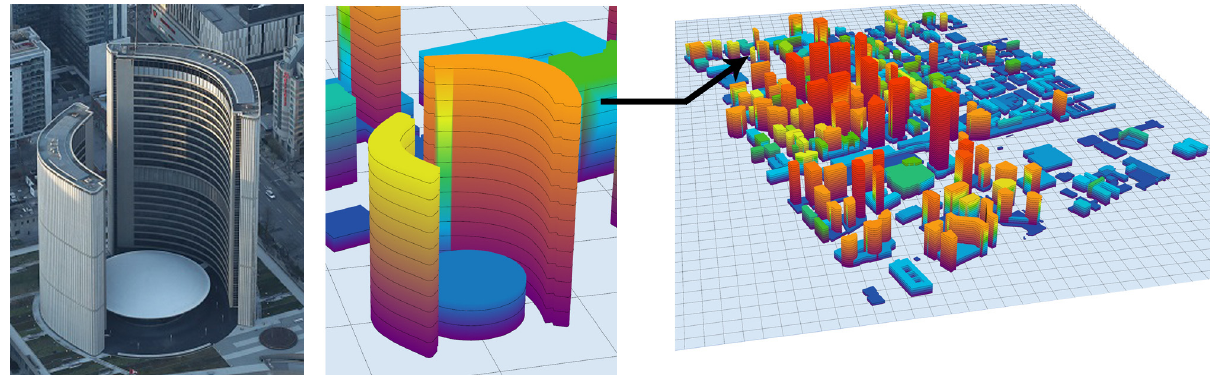
Figure 3. 3D digital-twin showing a zoom in on the Toronto city hall.